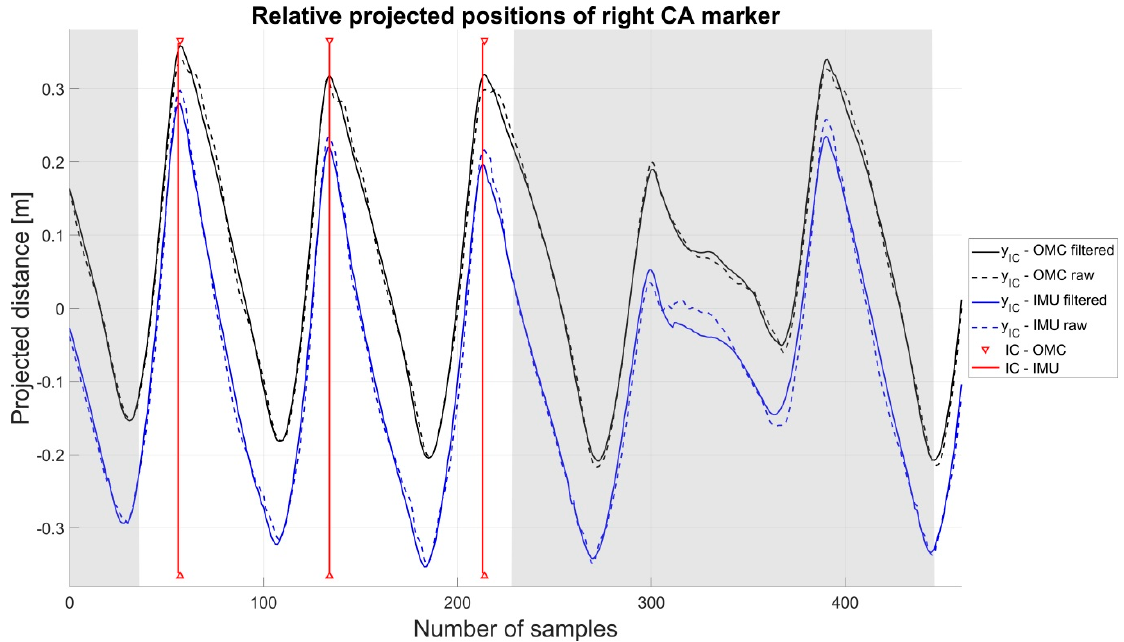
Figure 4. The shadowed areas indicate the turning phases. The offset between the OMC and IMU system originates in the different positions of the virtual and real heel marker as well as the different positions of the pelvis